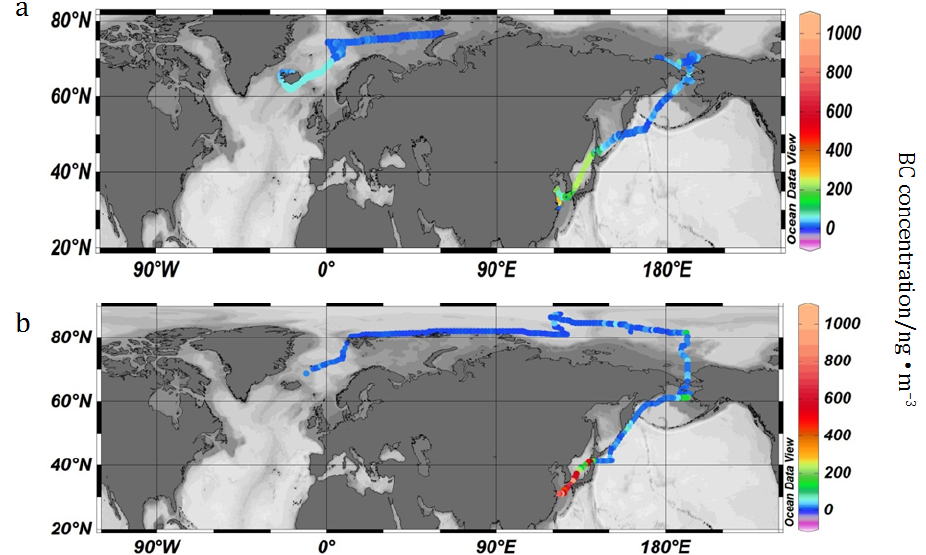
Figure 2. Hourly average concentrations of black carbon aerosols along the fifth CHINARE. ( a ) Departing route; ( b ) return